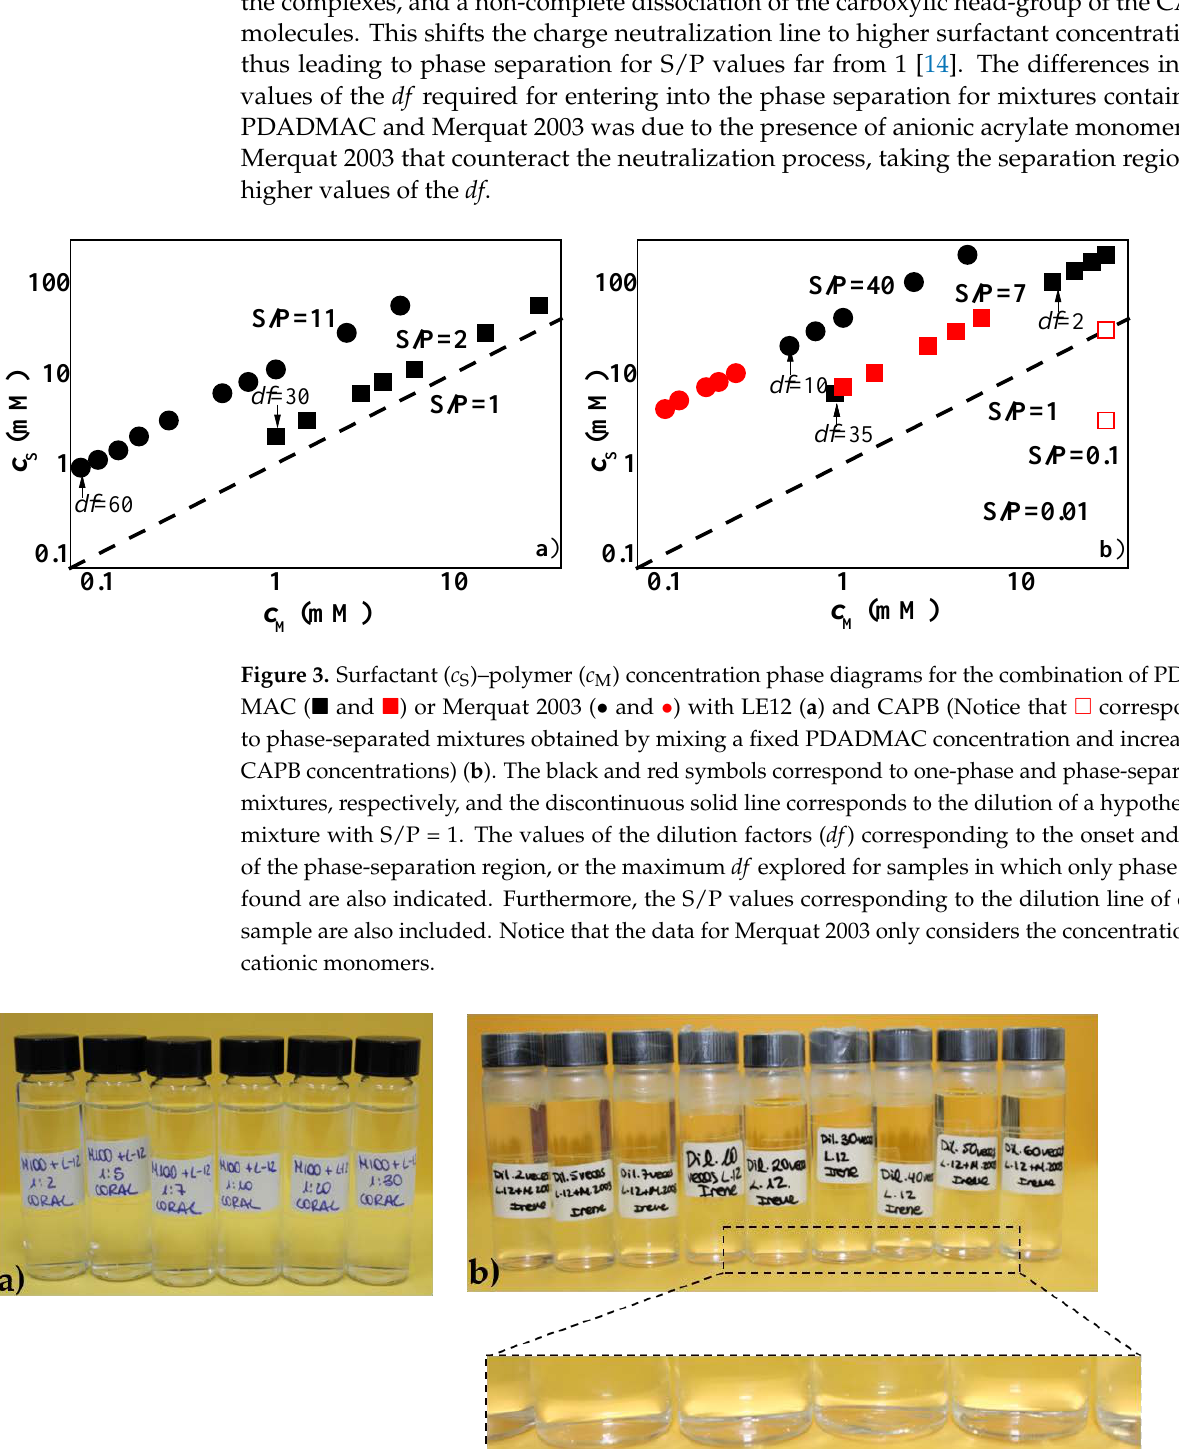
Figure 4. Set of images showing the dilution process (from left to right) of the pseudo-binary polymer–LE12 mixtures with the same composition of the components as that existing in the model mixture: ( a ) PDADMAC–LE12; ( b ) Merquat 2003–LE12. Panel ( b ) shows a more detailed image where the absence of phase separation is clear. In both panels, df increases from left to